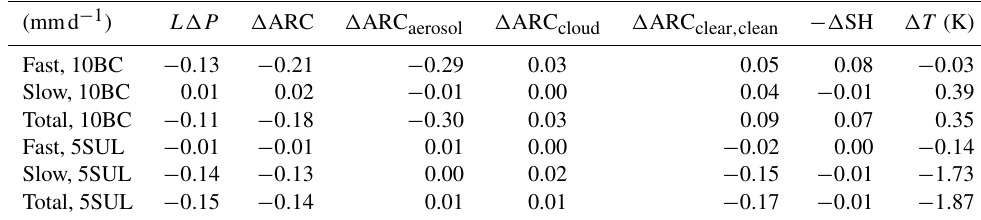
Table 1. ECHAM6–HAM2 simulated multi-annual global averaged fast, slow, and total responses of atmospheric energy budget terms (LP – the atmospheric latent heating rate from rainfall, ARC – atmospheric radiative cooling, SH – sensible heat flux) and surface temperature ( T ) in response to an increase of a factor of 10 in black carbon (BC) emission and a factor of 5 in sulfate (SUL) precursor emission. ARC has been further decomposed into the contribution from aerosols, clouds, and clear–clean sky. All terms are shown in equivalent precipitation units of mmd − 1